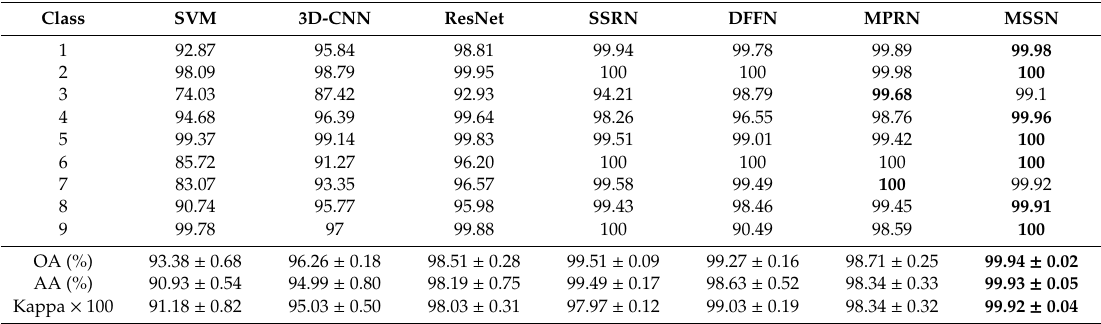
Table 5. Classification results obtained by di ff erent methods on the Pavia University data set. Data are Table 5. Classi fi cation results obtained by different methods on the Pavia University data set. Data given as mean ± standard are given as mean ± standard deviation .